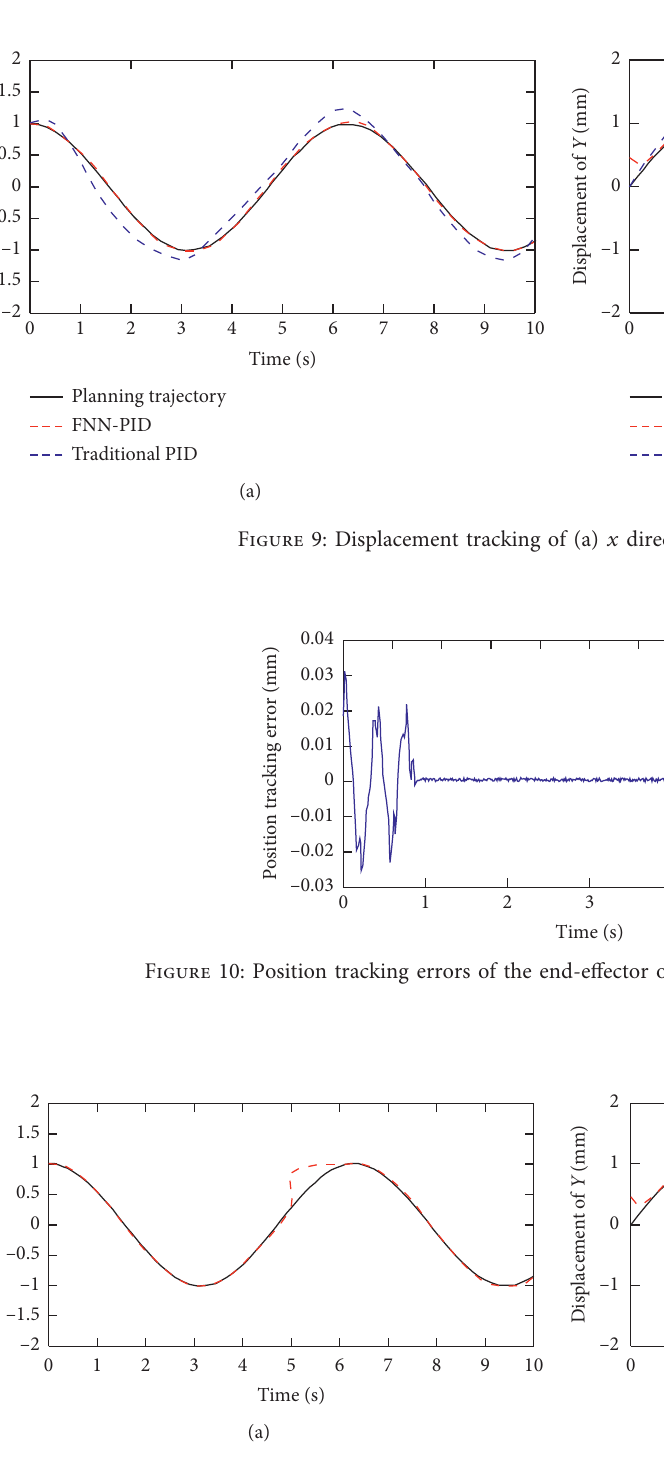
Figure 11: Displacement tracking (a) x direction and (b) y direction with external